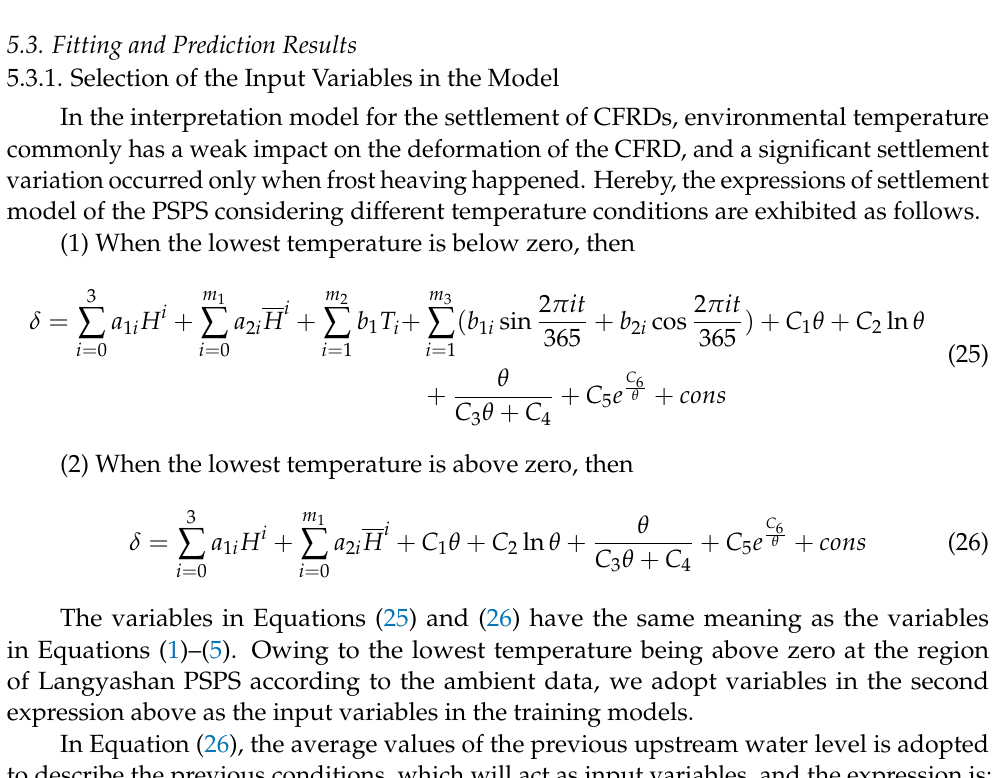
Figure 10. Plot of the objective function values versus the number of iterations. Table 1. Upper bound and lower bound of the parameters set in the CS algorithm, and the results of optimized parameters of the NN structure in LSTM model. Hidden Layers Hidden Nodes Learning Rate Upper bound 10 20 1 × 10 − 1 1 1 1 × 10 − 5 2 7 3 × 10 − parameters